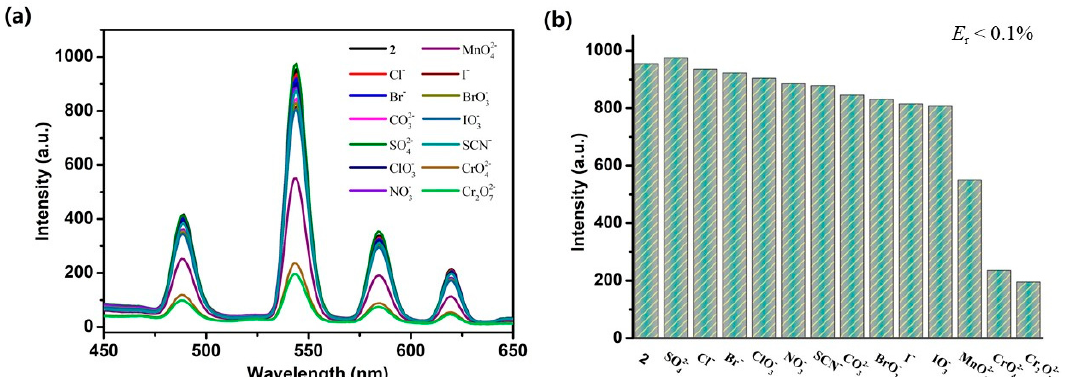
Figure 5. ( a ) The fluorescence spectra for compound 2 after the samples were dispersed in 0.005 mol/L concentration of aqueous solutions containing different metal ions; and ( b ) the enhancement or quenching efficiency histogram of compound 2 .